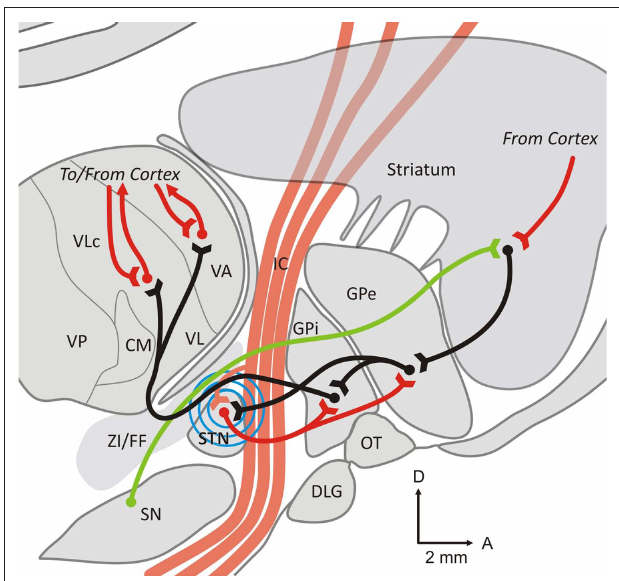
Figure 1 | Parasagittal slice through the monkey brain at the L7 level. The figure shows some of the major anatomical pathways that are affected by STN stimulation, and may contribute to the generation of cortical evoked potentials. Excitatory (glutamatergic) pathways are shown as red lines, inhibitory (GABAergic) connections are shown as black lines, and modulatory dopaminergic fibers as green lines. The blue circles symbolize the spread of the electrical stimulation of the STN. See text for further details. Abbreviations: CM, centromedian nucleus of the thalamus; DLG, lateral geniculate body; FF, Fields of Forel; IC, internal capsule; GPe, external pallidal segment; GPi, internal pallidal segment; OT, optic tract; Put, putamen; SN, substantia nigra; STN, subthalamic nucleus; VA, ventral anterior nucleus of the thalamus; VL, ventrolateral nucleus of the thalamus; ZI,